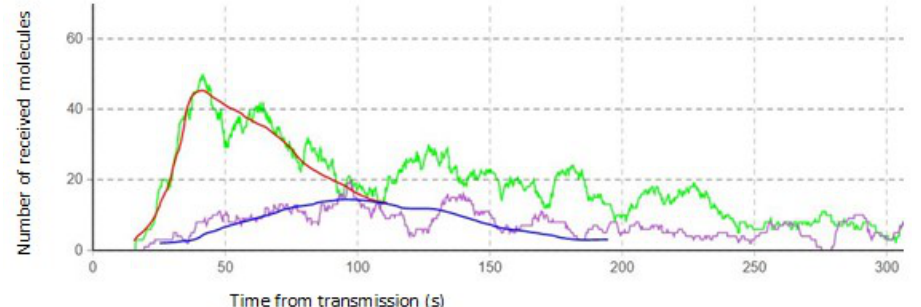
Figure 5. Red line shows a steeper curve (increased number of ascensions). Purple line shows a shallow curve (reduced number of ascensions with increased number of